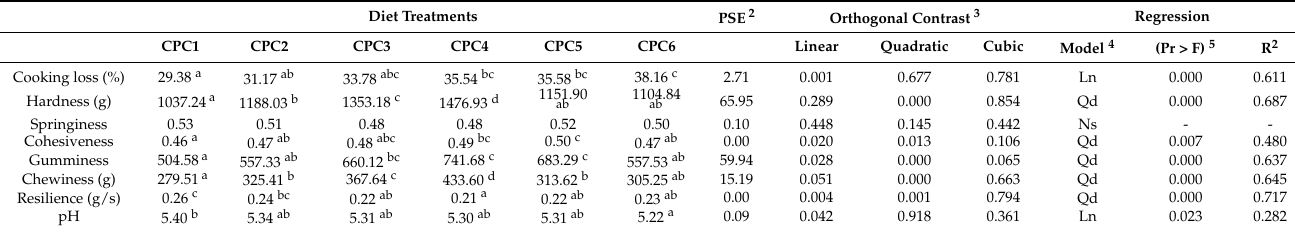
Table 6. Effects of the dietary protein levels on the muscle texture of grass carp 1 .